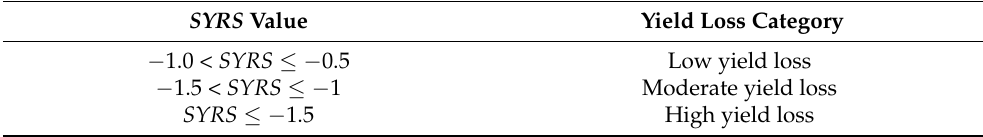
Table 2. The categories for yield loss based on the SYRS